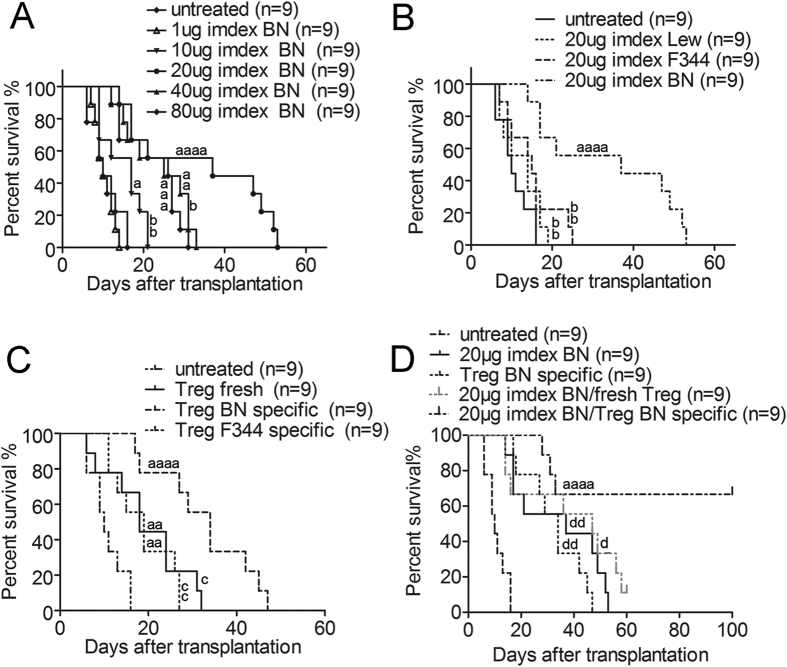
Administration of donor imDex, different Tregs or both combined promotes liver allograft survival.(A) The percentage of surviving liver allografts with different dosages of donor imDex. (B) ImDex derived from donors (BN), recipients (Lewis), or other allogeneic donors (F344) were injected at 20 μg into recipient rats. (C) Recipients were treated with different Tregs. (D) The liver allograft survival with the administration of 20 μg imDex and/or BN-specific/fresh Tregs. aCompared with untreated group; bcompared with 20 μg BN derived imDex treatment group; ccompared with BN-specific Tregs treatment group; dcompared with 20 μg imDex plus BN specific Tregs treatment group. One a/b/c/d, p < 0.05; two a/b/c/d, p < 0.01; three a/b/c/d, p < 0.001; four a/b/c/d, p < 0.0001.